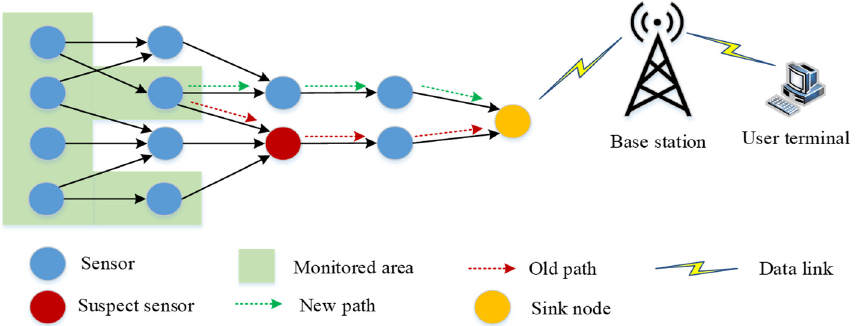
Figure 3. Example of sensor failure.